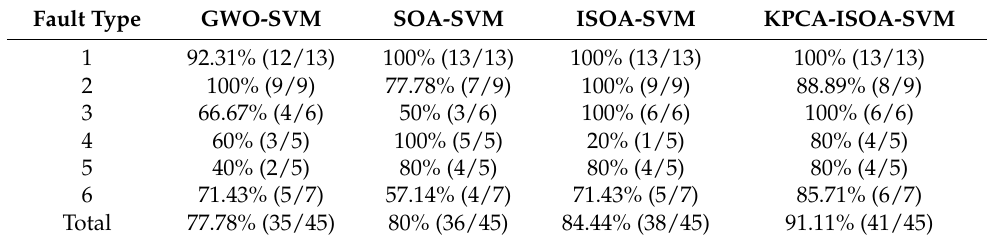
Table 8. Fault model diagnosis